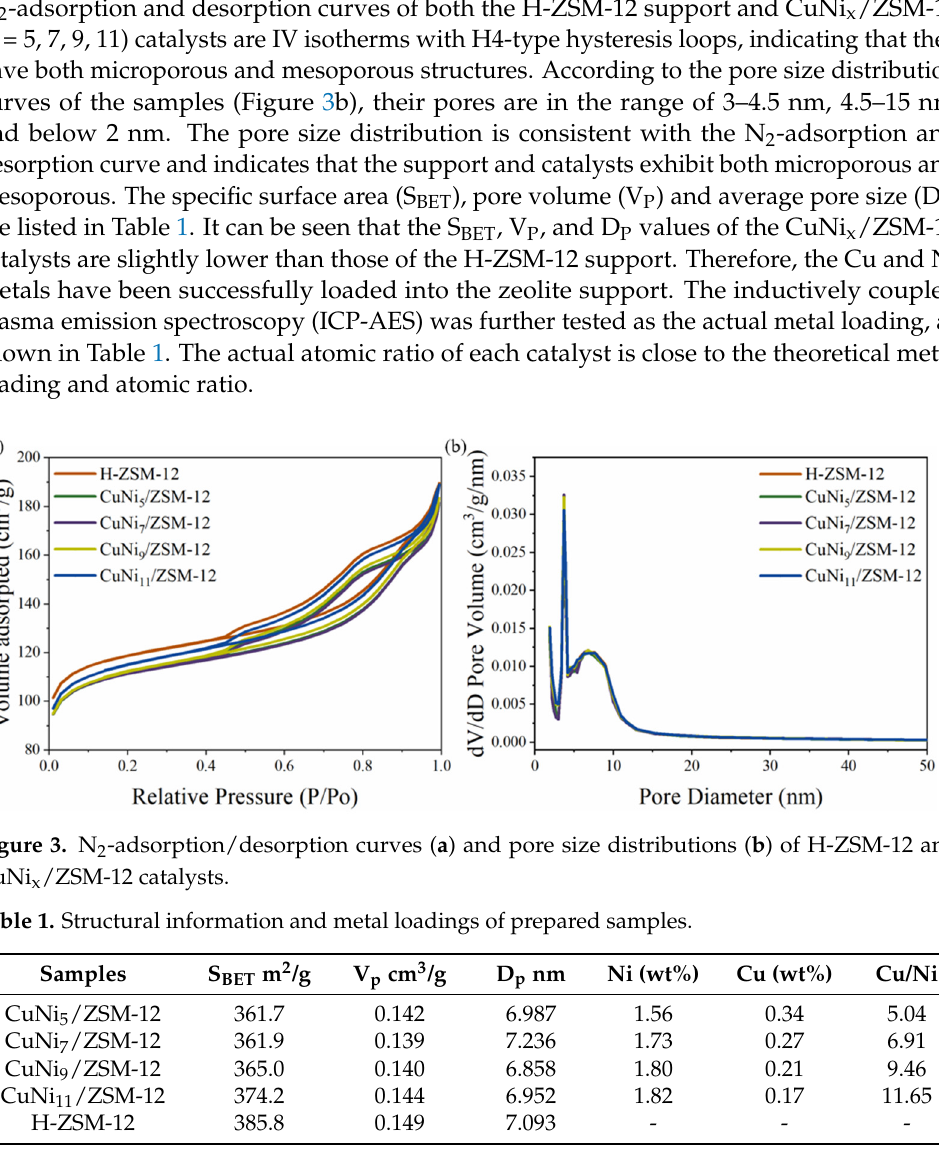
Figure 2. ( a , b ) The SEM results of Ni 7 Cu/ZSM-12; ( c , d ) SEM results of Ni 7 Cu/ZSM-12 after stability test; ( e , f ) the TEM results of Ni 7 Cu/ZSM-12; ( g – o ) EDS line profile results of Ni 7 Cu/ZSM-12.